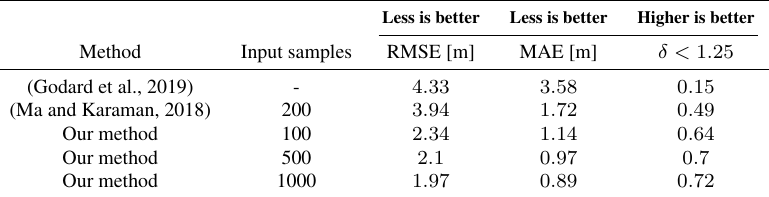
Table 1. Evaluation performed on our test set of forest images. The metric δ represents the threshold accuracy of the model. Our method significantly outperforms both state-of-the art methods in terms of RMSE, MAE, and δ for forest environments.